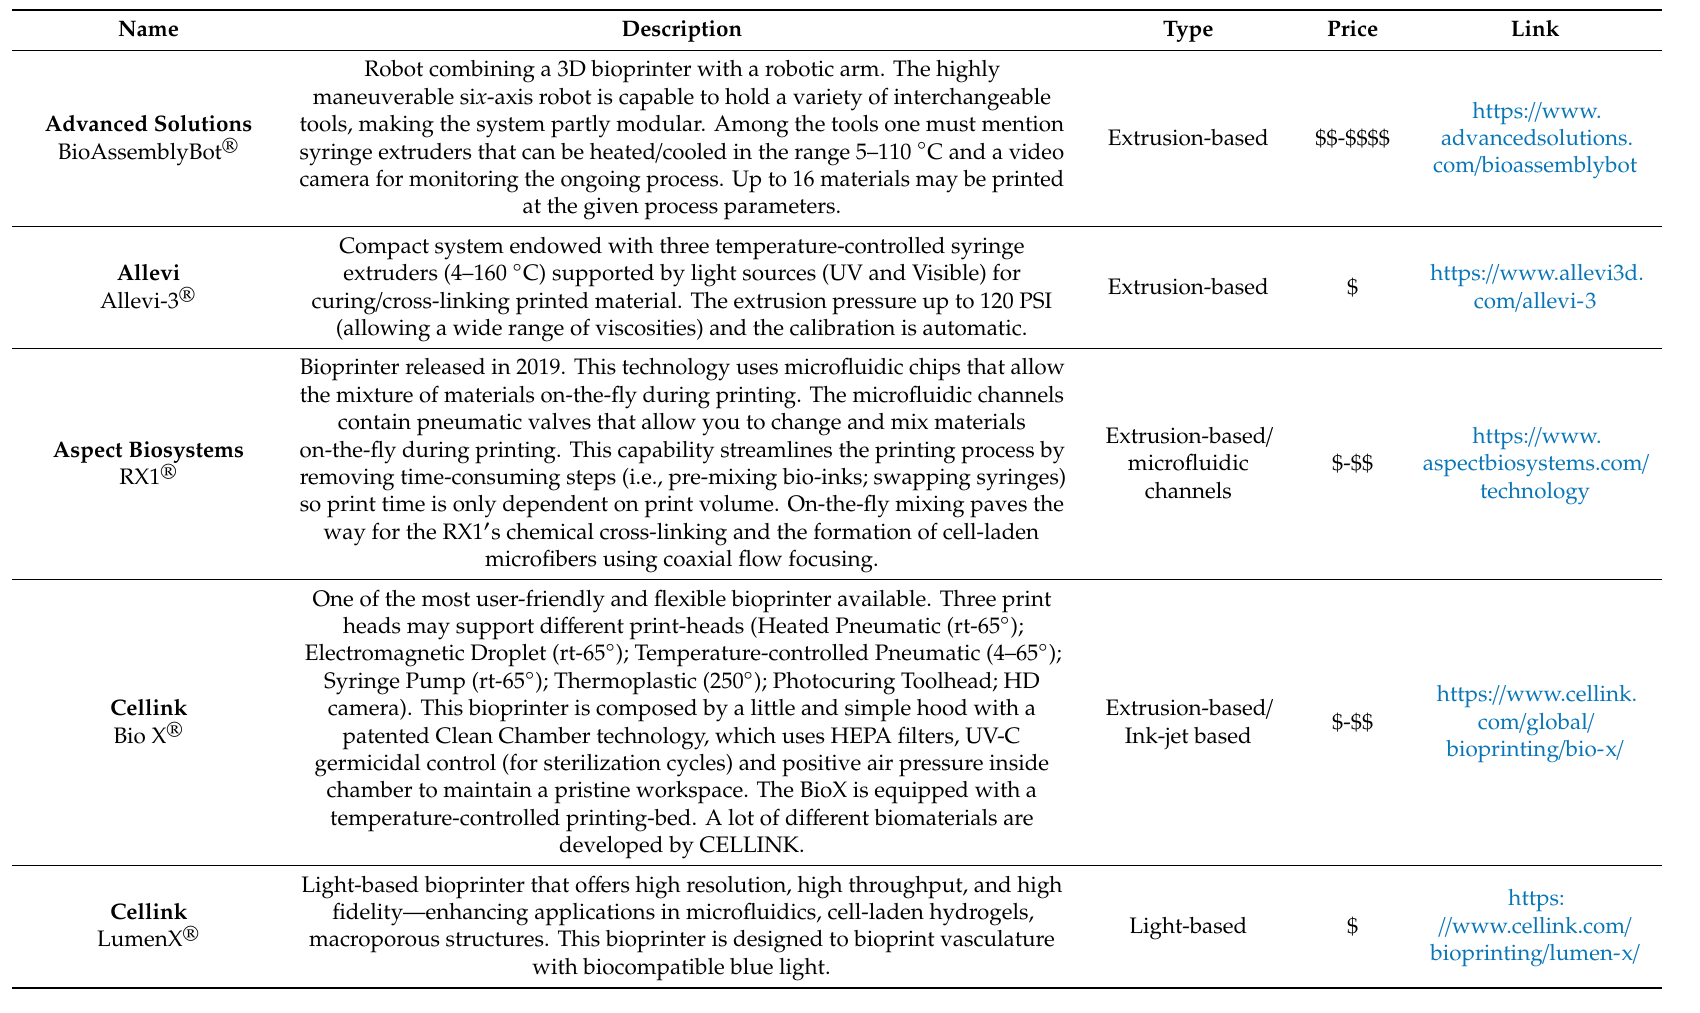
Table 3. In the table are reported the names with a brief description of the main available bioprinters and their price range (legend: 0–50k$ = $; 50–100k$ =